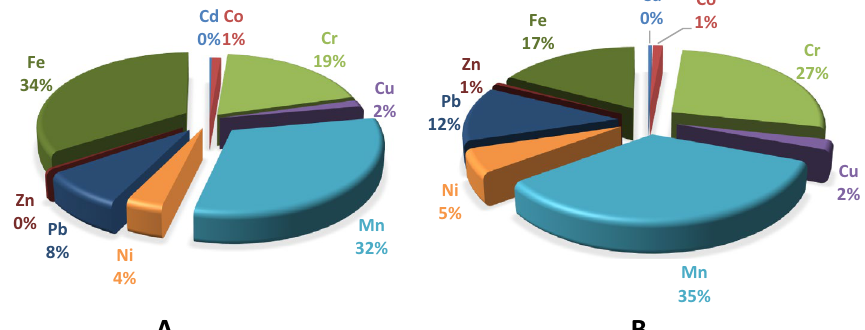
Figure 2. Contribution of different elements to HI for ( A ) adults and, ( B )